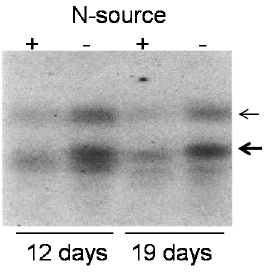
Figure 2. Induction of OsY37 expression under nitrogen starvation conditions. Rice cv. “Akitakomachi” seeds were sown on soil and grown to the juvenile seedling stage. Whole seedlings were transferred to pots containing vermiculite with (+) or without ( − ) a nitrogen source. After the indicated number of days, RNA (100 µg) was extracted and Northern hybridization analysis was performed as described in Figure 1. Thick and thin arrows correspond to 1 and 3–4 kb transcripts, respectively.